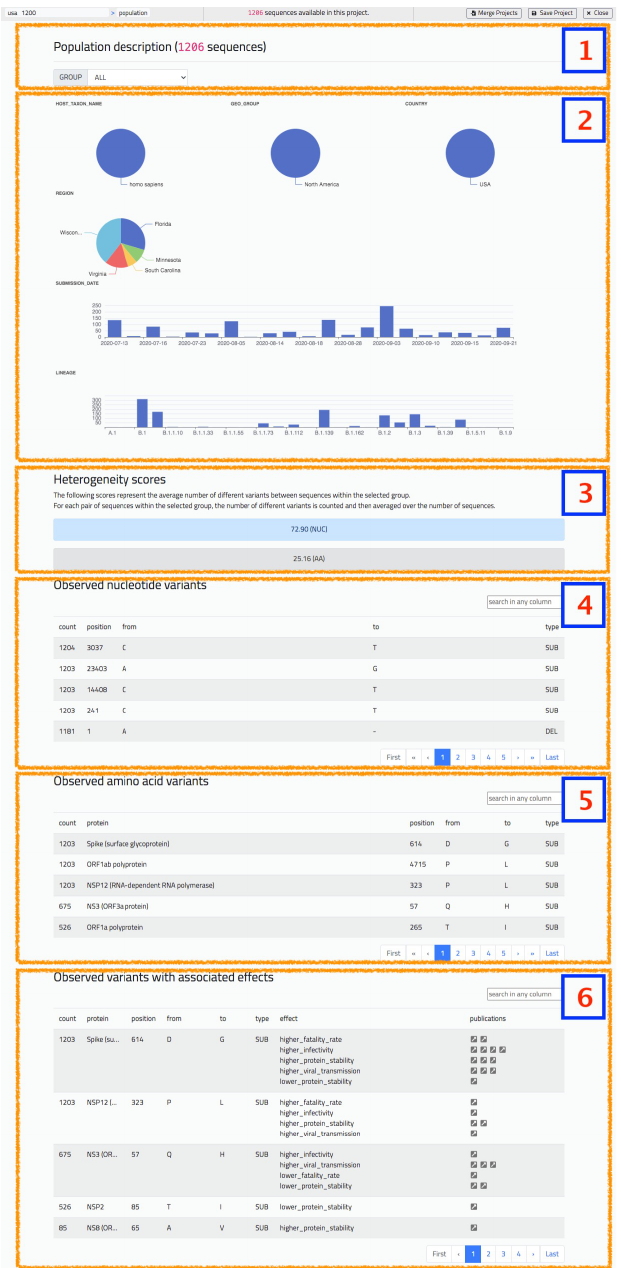
Figure 6. The ‘Population’ screen of VirusLab offers a general overview of characteristics of the uploaded